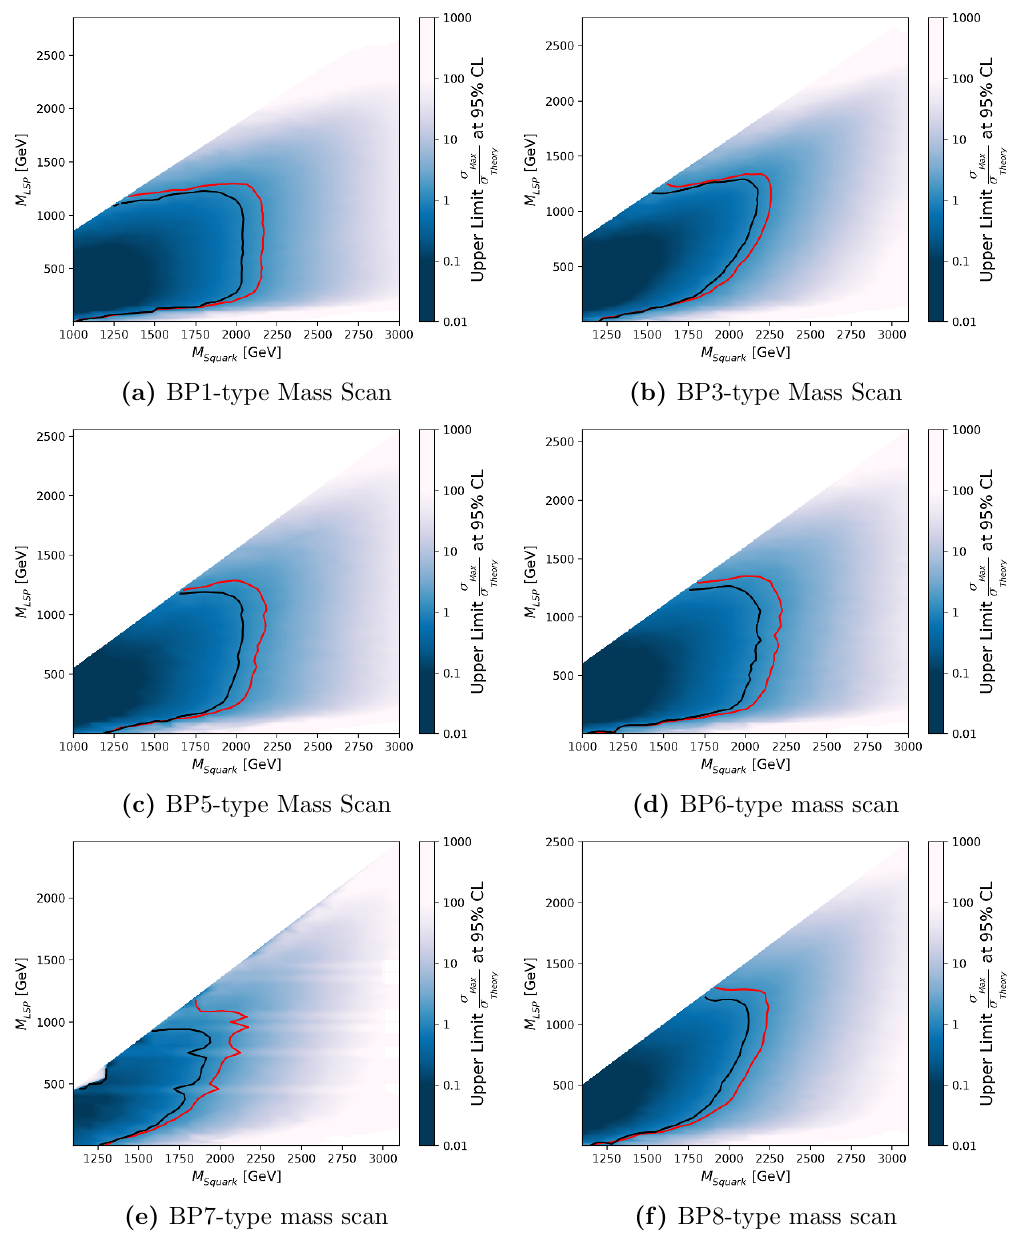
Figure 16. Observed and expected limits for the BP1-BP8-type mass scans. The X - and Y -axes represent the squark and LSP masses, respectively, whilst the colour scale represents the upper limit on the strength parameter (cid:22) .